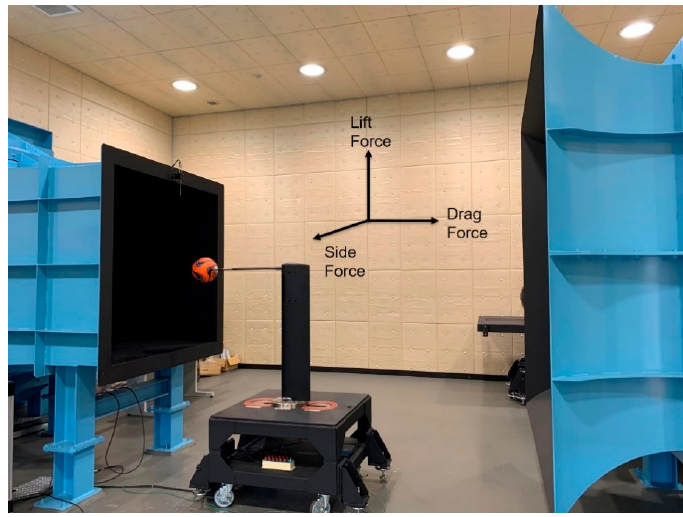
Figure 1. Wind-tunnel setup.